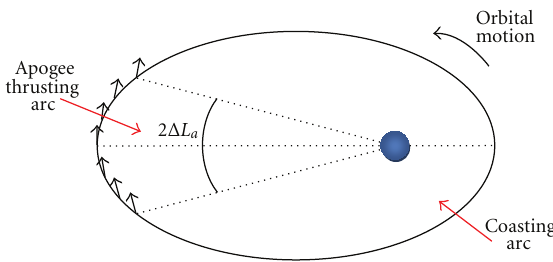
Figure 2: Thrusting arc around apogee with thrust directed along transverse